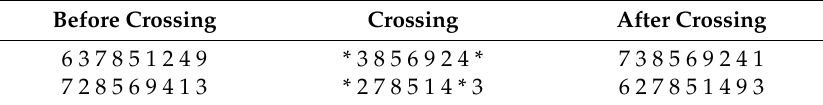
Table 2. Cross-operation